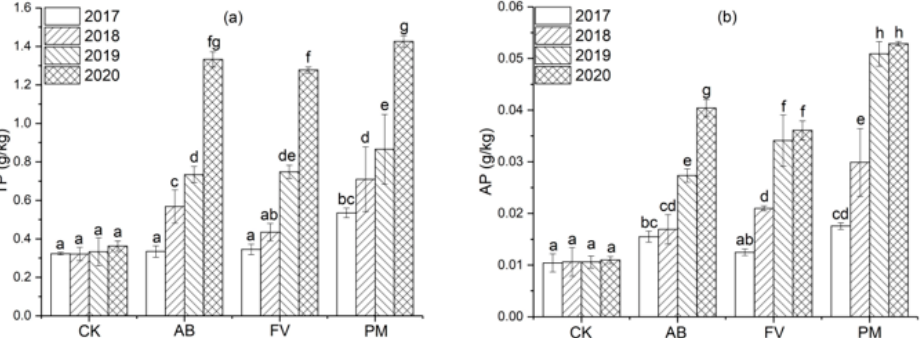
Figure 3. ( a ) Effects of the different fertilizer treatments on the content of TP in the soils; ( b ) Effects of the different fertilizer treatments on the content of AP in the soils. Data are expressed as means ± SD; n = 3. Different letters on data in the same group indicate a significant difference between them at p < 0.05 level.